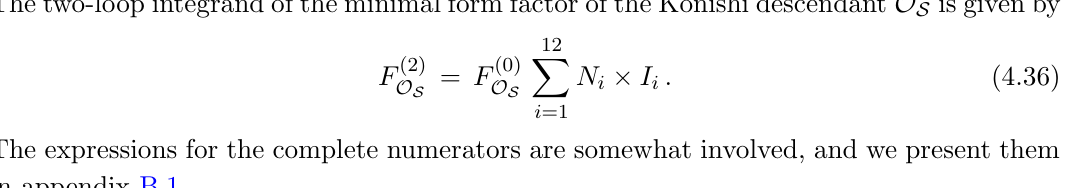
(1 + ; 2 + ; 3 + ; q ) in N =4 O S ; O C